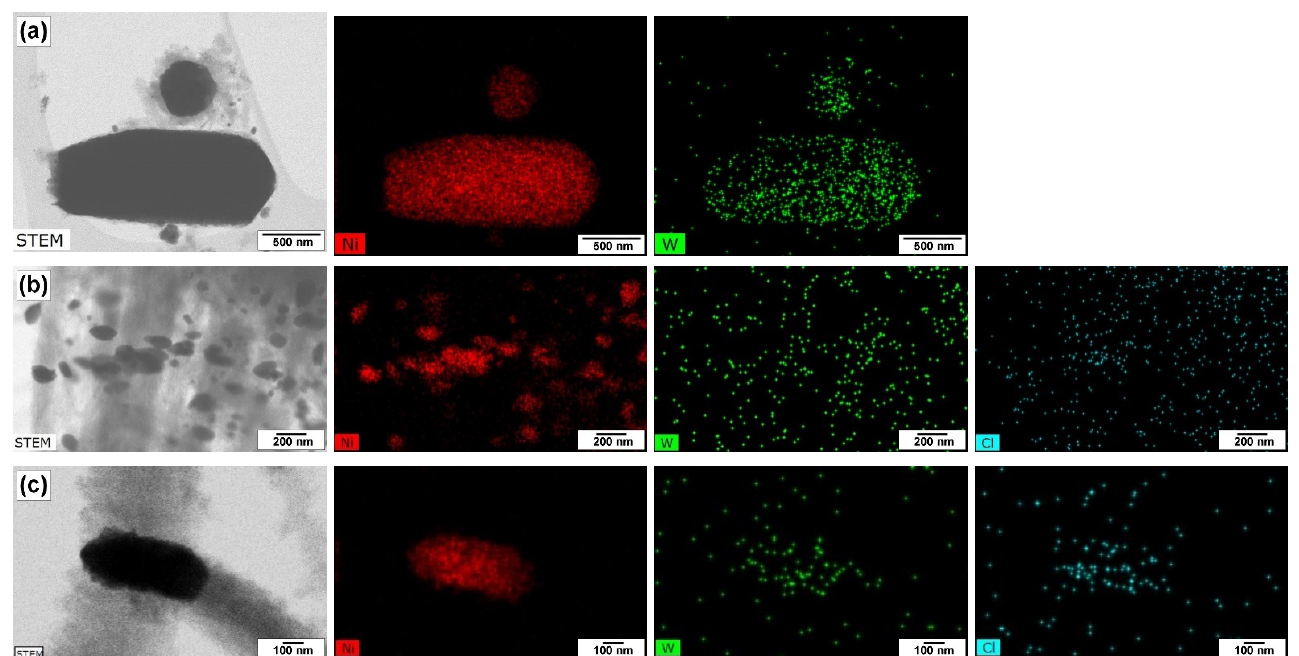
Figure 5. TEM images of the carbon nanomaterials and the catalytic particles formed as a result of carbon erosion of 96Ni-4W alloy during its interaction with TCE at 500 °C for 2 min ( a – c ), 5 min ( d – f ), 10 min ( g – i ), and 15 min ( j – l ).